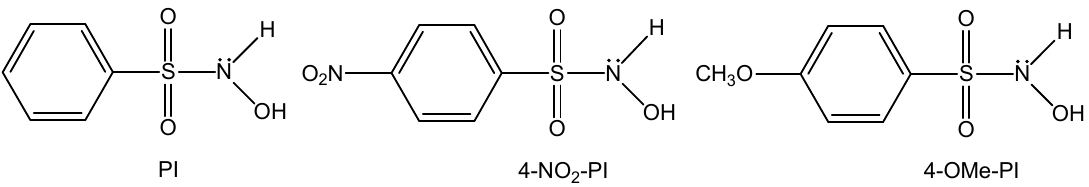
Figure 2. Structure of N -hydroxy-benzenesulfonamide (PI), N -hydroxy-4-nitrobenzenesulfonamide (4-NO 2 -PI) and N -hydroxy-4-methoxybenzenesulfonamide (4-OMe-PI).